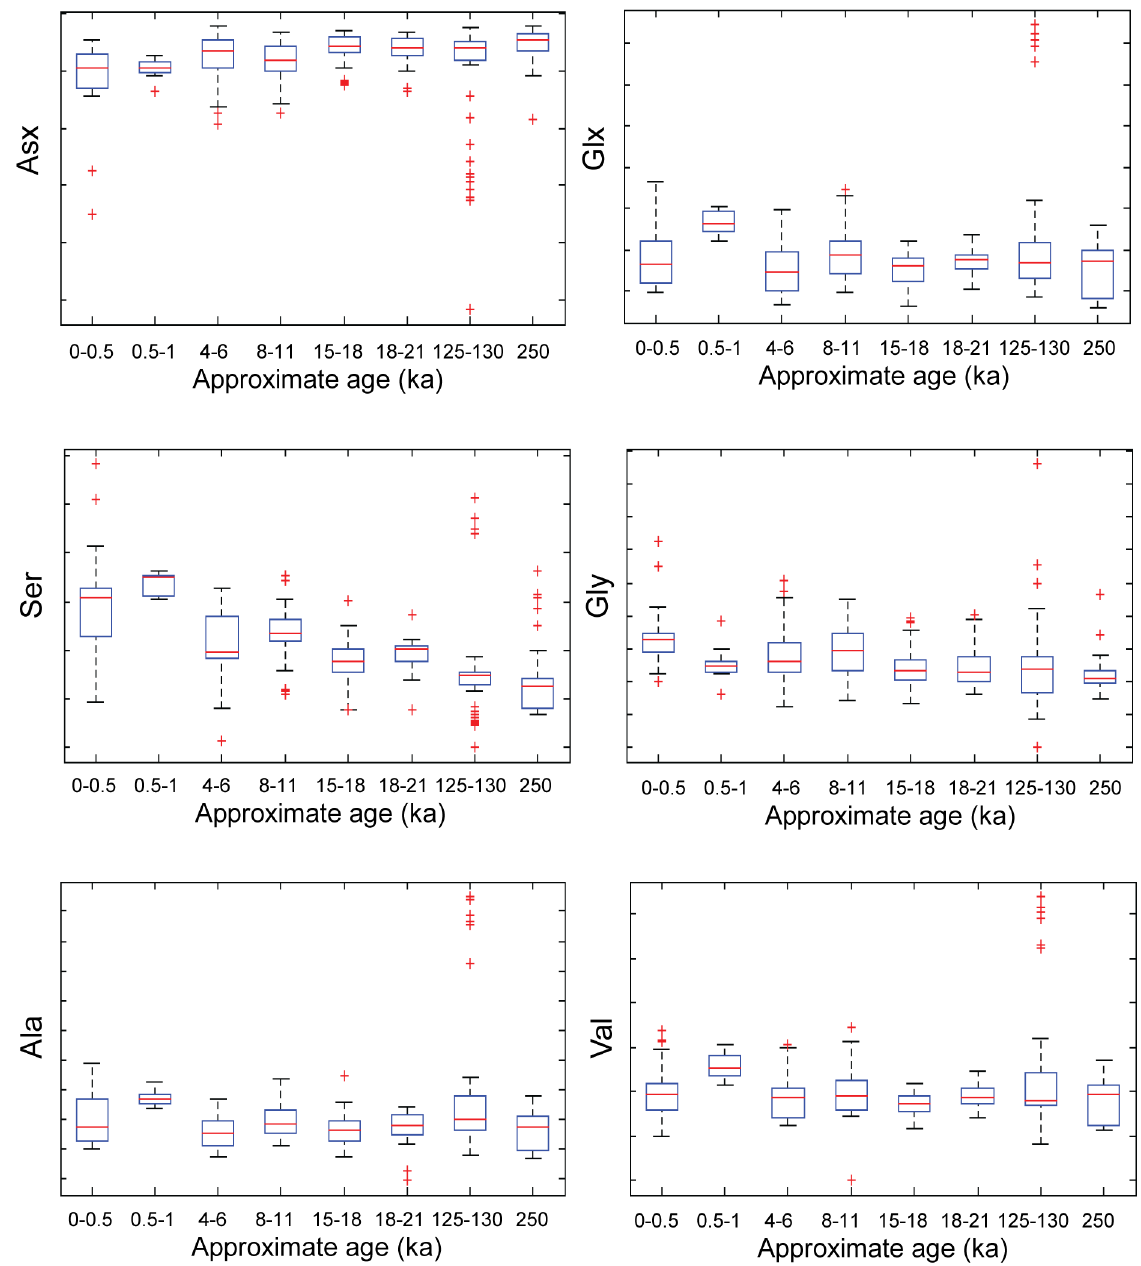
Figure 1. Amino acids distributions for Patella . Boxplots showing the distribution of concentrations with age for individual amino acids in shells of genus Patella . Concentrations are relative (y-axis units are arbitrary), having been normalised so that the sum over the six amino acids is the same for each sample. For each age group, the rectangular box shows the inter-quartile range with the median indicated by the line inside. The "whiskers" extending from each box show the maximum/minimum values unless these extend more than 1.5 times the inter-quartile range: any examples beyond this are indicated by crosses.